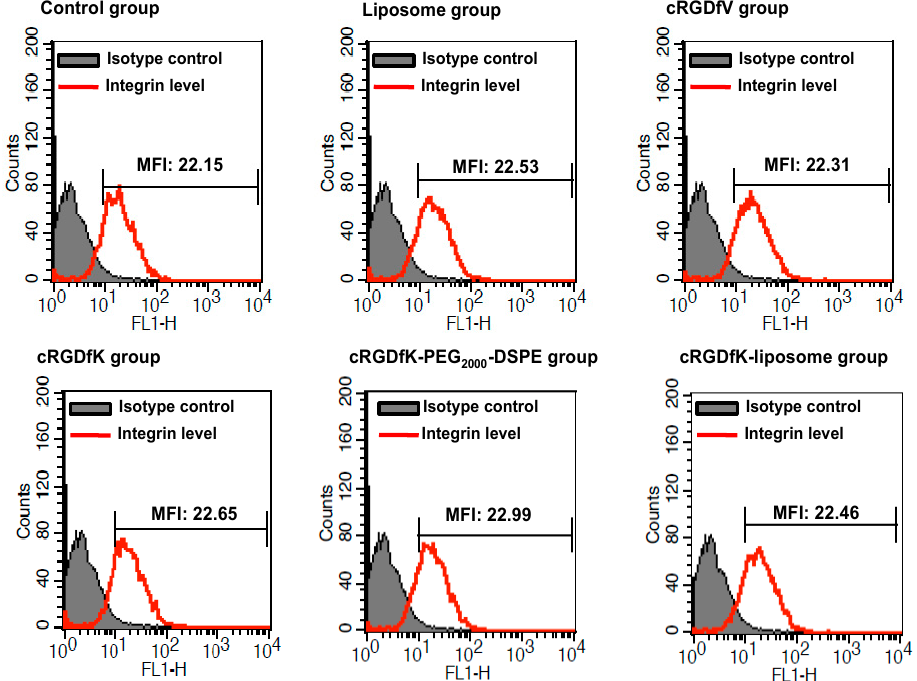
Figure 1. Evaluating the effect of the cyclic RGDfK-liposome on α V β 3 integrin-mediated cell adhesion. ( A ) The cyclic RGDfK-liposome preparation was showed. A375.S2 cells was pretreated with 100 nM cRGDfV, cRGDfK, cRGDfK-PEG 2000 -DSPE or the cRGDfK-liposome and allowed to adhere to a coating of fibronectin, collagenI or collagen IV for 1 h at 37 ◦ C before washing and detection of cell adhesion ( B ) or followed by staining with FITC-labeled mouse anti-human CD51/CD61 monoclonal antibody ( C ). The black star indicated p < 0.01 and duplicate black stars for p < 0.05, when compared with liposome group; N.S., non-significant. These experiments were performed for five times.